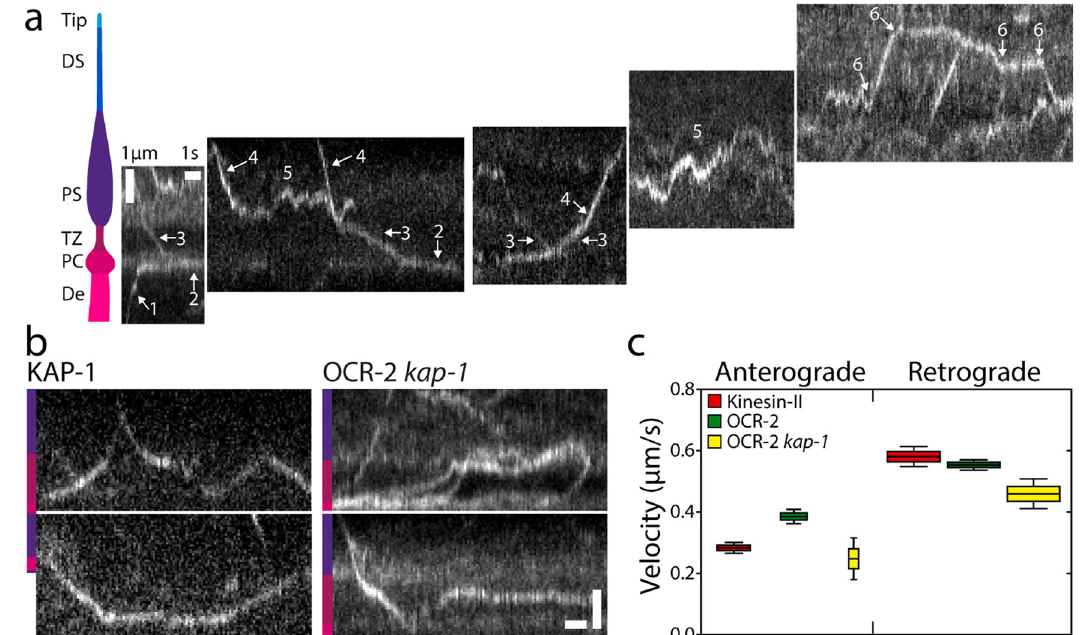
Fig. 2 Single-molecule imaging of OCR-2. a Cartoon of the ciliary segments and representative single-molecule kymographs of OCR-2::EGFP. Scale bars, vertical: 1 μ m, horizontal: 1 s. b Single-molecule kymographs showing TZ crossings of Kinesin-II (KAP-1::EGFP) and OCR-2::EGFP kap-1 (ok676). Color bars indicate ciliary segment as in (A). Scale bars, vertical: 1 μ m; horizontal: 1 s. c Anterograde (A) and retrograde (R) velocity of KAP-1::EGFP (A: 63 trajectories; R: 273 trajectories), OCR-2::EGFP (A: 51 trajectories; R: 297 trajectories) and OCR-2::EGFP kap-1 (ok676) (A: 19 trajectories; R 141 trajectories). Velocities were extracted using KymographDirect from kymographs optimized for the TZ (a different data set than used in the rest of the manuscript). Data are represented as boxplot. Indicated are median (block horizontal line), 25th – 75th percentile (height of the colored boxes), 5th – 95th percentile. The widths of the boxes represent the sample